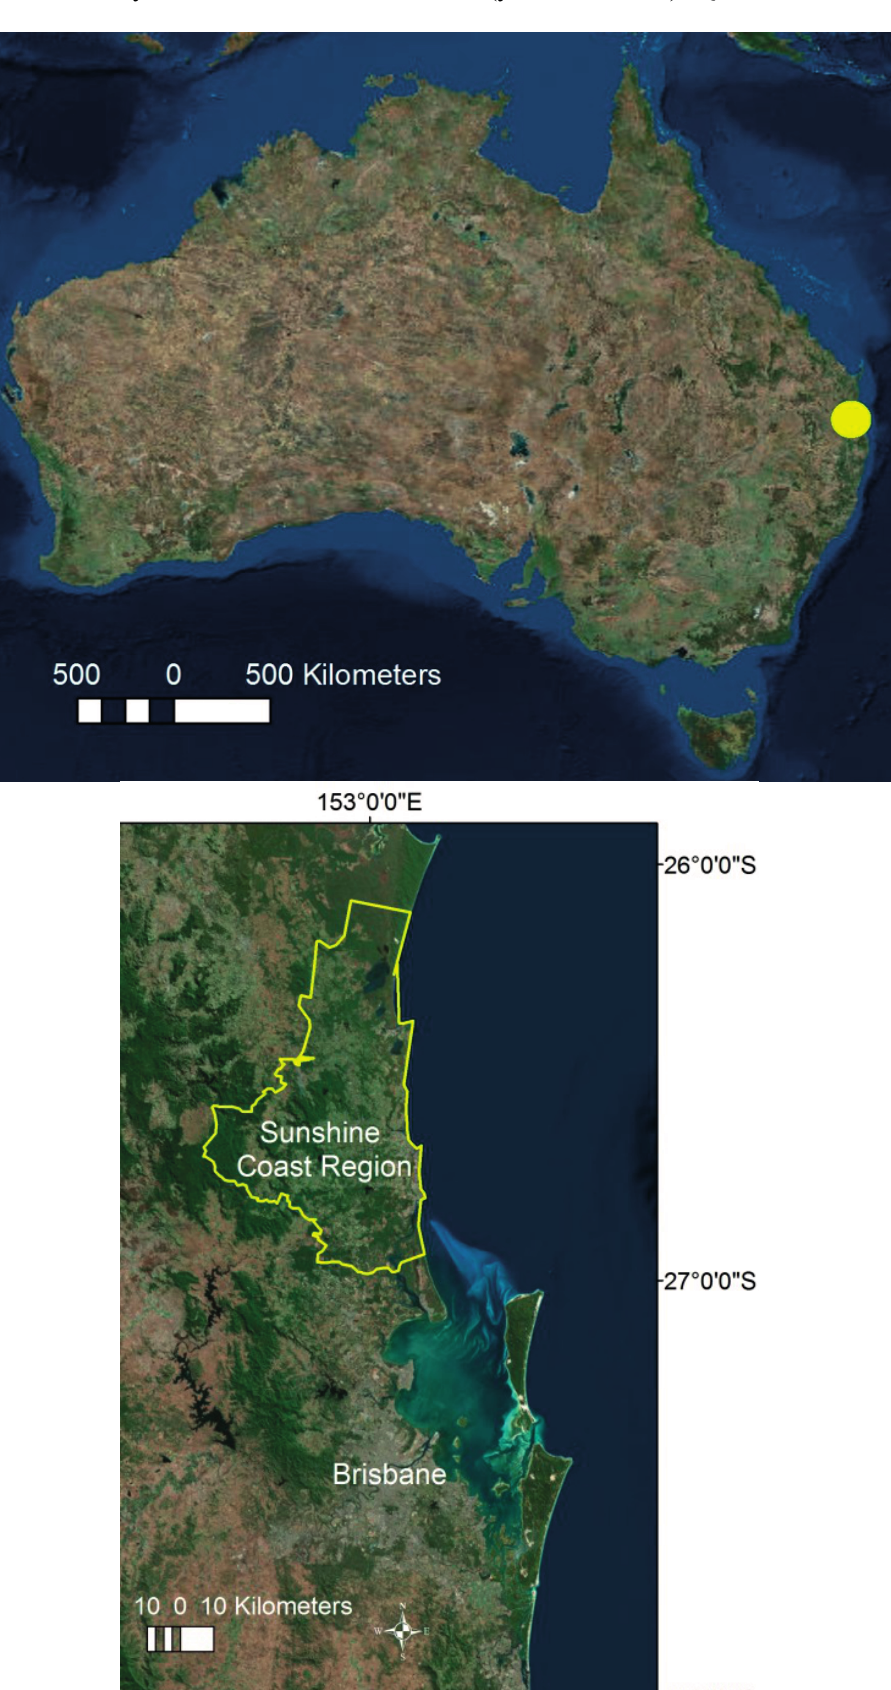
Figure 1. The study area on the Sunshine Coast (yellow outline), Queensland,